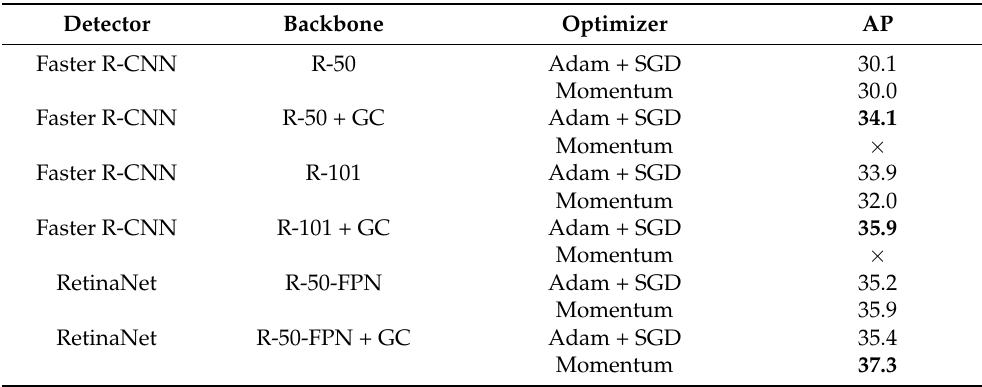
Table 6. Comparisons between two optimizers, Adam + SGD and SGD with momentum, on the COCO val2017 dataset. Here ResNet is abbreviated as “R”. The number in bold means superiority compared to that of the baseline in the metric. When training Faster R-CNN with ResNet + GC backbone, Adam optimizer and finetuning with SGD optimizer can successfully train the model while SGD optimizer with momentum diverges (marked as × ). In the case of training RetinaNet, which uses FPN by default, SGD with momentum optimizer can train the model successfully. It seems that FPN helps the optimization